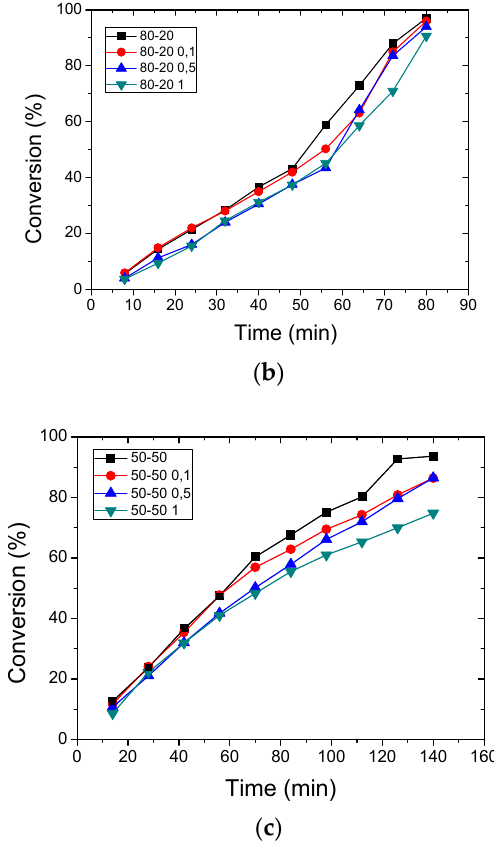
Figure 4. Conversion versus time curves of neat PMMA and PMMA/GO nanocomposites with different relative amounts of GO obtained from in situ polymerization at 80 °C with a 0.03 mol/L initial initiator concentration in bulk ( a ); in solution 80–20 ( b ); 50–50 ( c ).